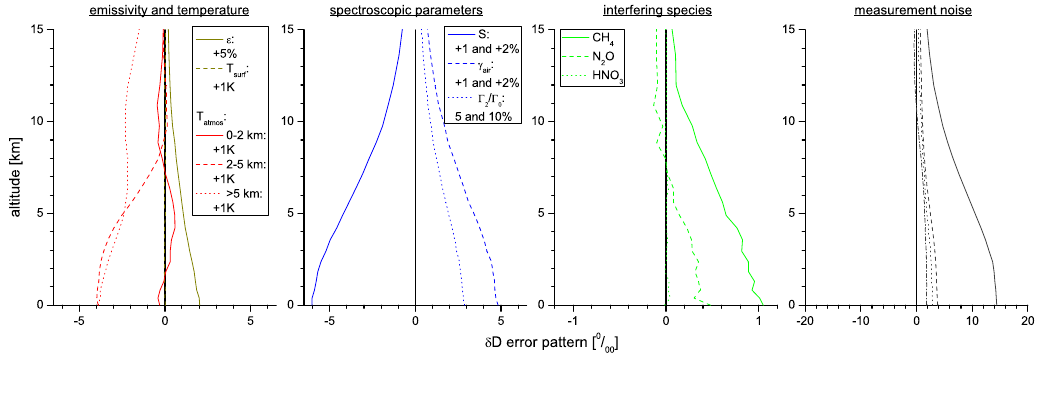
Fig. 5. Same as Fig. 4 but for δ D.